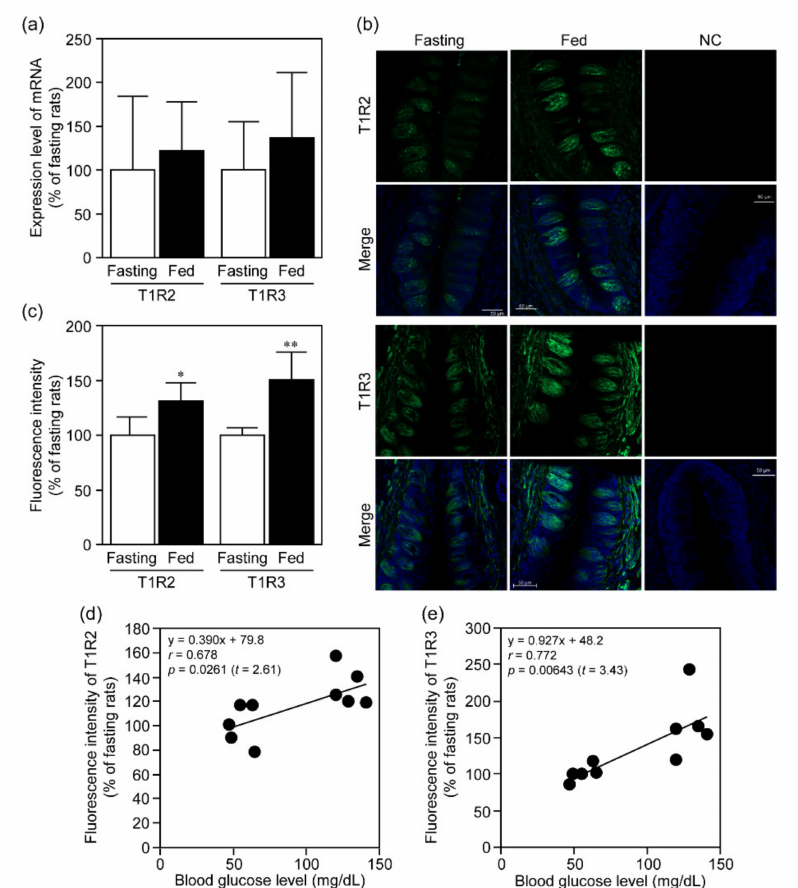
Figure 2. Expression of T1R2 and T1R3 in rat CP under fasting and fed conditions. After 18 h-fasting with or without subsequent 4 h-fed treatment of rats, the expression levels of T1R2 and T1R3 in CP isolated from their tongues were determined by real-time PCR ( a ) and immunohistochemical analysis ( b , c ). In panel a , mRNA expression levels of T1R2 and T1R3 were normalized against the corresponding levels of β -actin mRNA. In panel b , green and blue signals indicate expression of T1R2 or T1R3 and nuclei, respectively, and the results for fluorescence intensity derived from the immunoreactivity of T1R2 and T1R3 are given in panel c . In panel b , we linearly adjusted the contrast of whole images including the background by changing the input value from 255 to 200 in the images for T1R2 in fasting and fed groups. NC (negative control) was prepared by omitting the primary antibodies. Bar = 50 µ m. Each bar represents the mean ± SD for 4 ( a ), and 4 (fasting of T1R3) or 5 (fasting and fed T1R2 and fed T1R3) ( b , c ) rats. * p < 0.05 and ** p < 0.01 (vs. fasting). Panels d and e indicate correlation between blood glucose levels and expression levels of T1R2 or T1R3 in